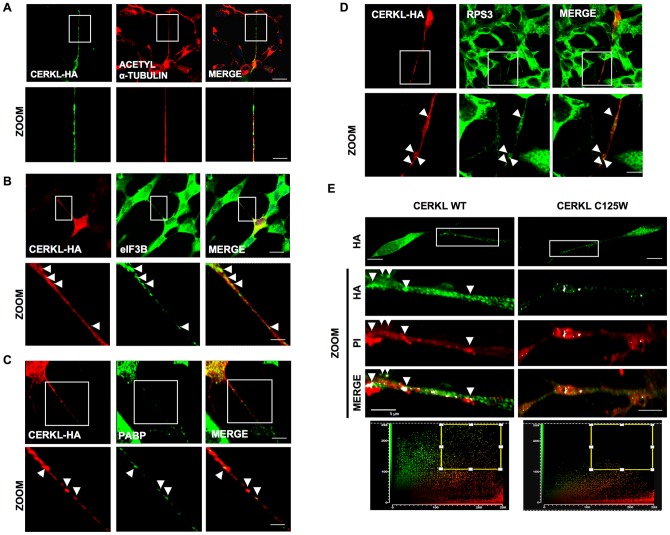
CERKL localization in differentiated SH-SY5Y neural cells.
A) SH-SY5Y cells were transfected with CERKL-HA and after 48 h cells were differentiated with 10 µM retinoic acid. The distribution of CERKL and acetyl-α-tubulin were compared after 36 h by immunofluorescence. Images at higher magnification of the rectangles in the upper row are shown below. B–D) SH-SY5Y were transfected and differentiated as in A. Images show colocalization by immunofluorescence of CERKL (HA) with eIF3B (B), PABP (C) and RPS3 (D) in differentiated SH-SY5Y cells. Images at higher magnification of the rectangles in the upper row are shown below. E) Colocalization of CERKL-WT and CERKL-C125W (HA) with RNA (propidium iodide staining, PI) in differentiated SH-SY5Y cells. Arrowheads show colocalization in particulated structures. The scatter diagrams below show colocalization dots. Bars: 10 µm (original images) and 5 µm (zoom).